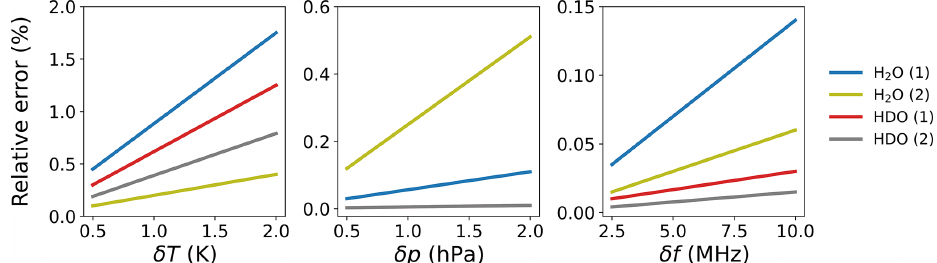
Figure 7. Maximal relative error in the VMR retrieval (over 3km range, mid-latitude baseline) due to uncertainties in the profiles of tem- perature ( δT ) and atmospheric pressure ( δp ) as well as transmitter on- and off-line wavelength ( δf ). The parenthetical numbers (1) and (2) stand for the two possible on-line wavelength options for measuring H 2 O. Table 3. Systematic errors for mid-latitude, arctic and tropical atmospheric models (maximal error over 3km range). The parenthetical numbers (1) and (2) denote the two wavelength options for H 2 O and HDO